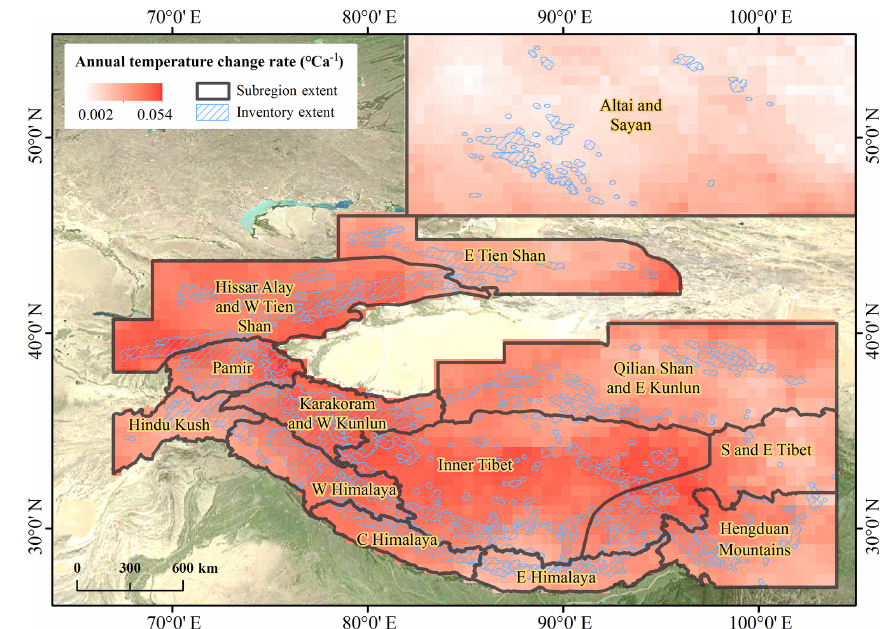
Figure 1. Location of subregions, rate of change in air temperature (1990–2018), and buffer area within 10km of glacier extent for glacial lake inventory of high-mountain Asia.